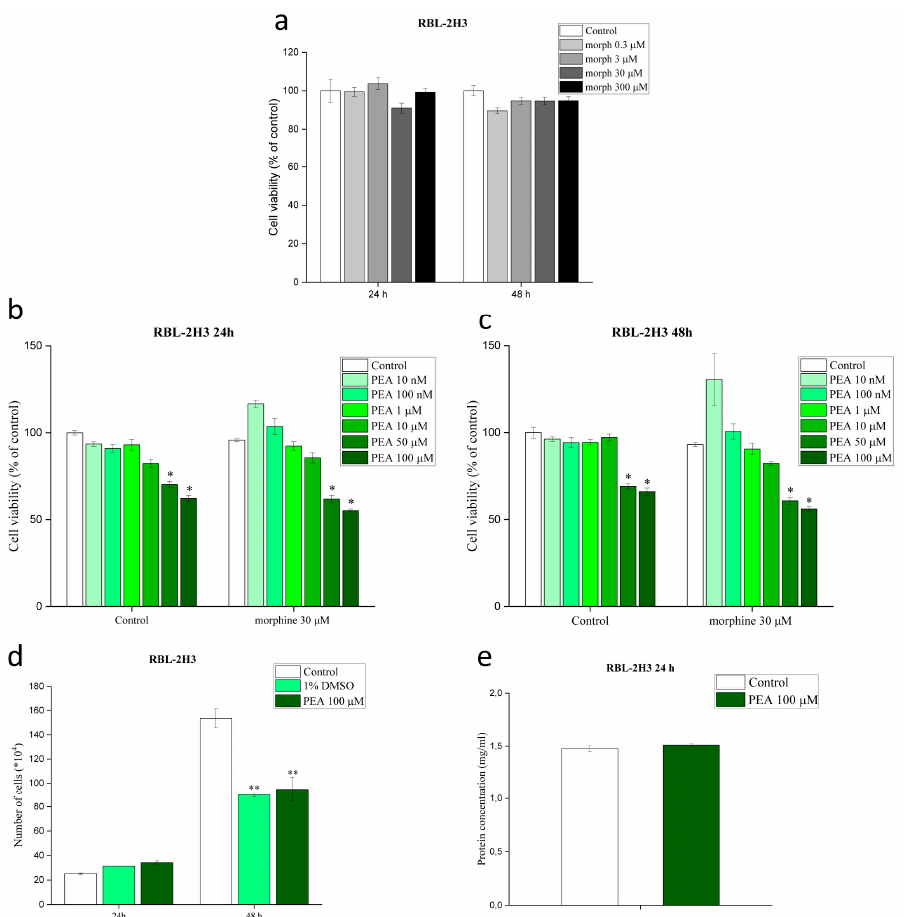
Figure 1. Effect of morphine and N -palmitoylethanolamine (PEA) on MC viability. ( a ) MTT of RBL-2H3 cells treated with increasing concentrations of morphine (0.3–300 µ M) for 24 and 48 h; ( b , c ) MTT of RBL-2H3 treated with increasing concentrations of PEA (10 nM-100 µ M) alone or in combination with 30 µ M morphine for 24 and 48 h; control condition was arbitrarily set as 100%; ( d ) Cell count of RBL-2H3 cells treated with PEA 100 µ M and 1% DMSO at 24 and 48 h; ( e ) Protein content in RBL-2H3 cells treated for 24 h with PEA 100 µ M. Values are expressed as the mean ± S.E.M. of three experiments. * p < 0.05; ** p < 0.01 vs.